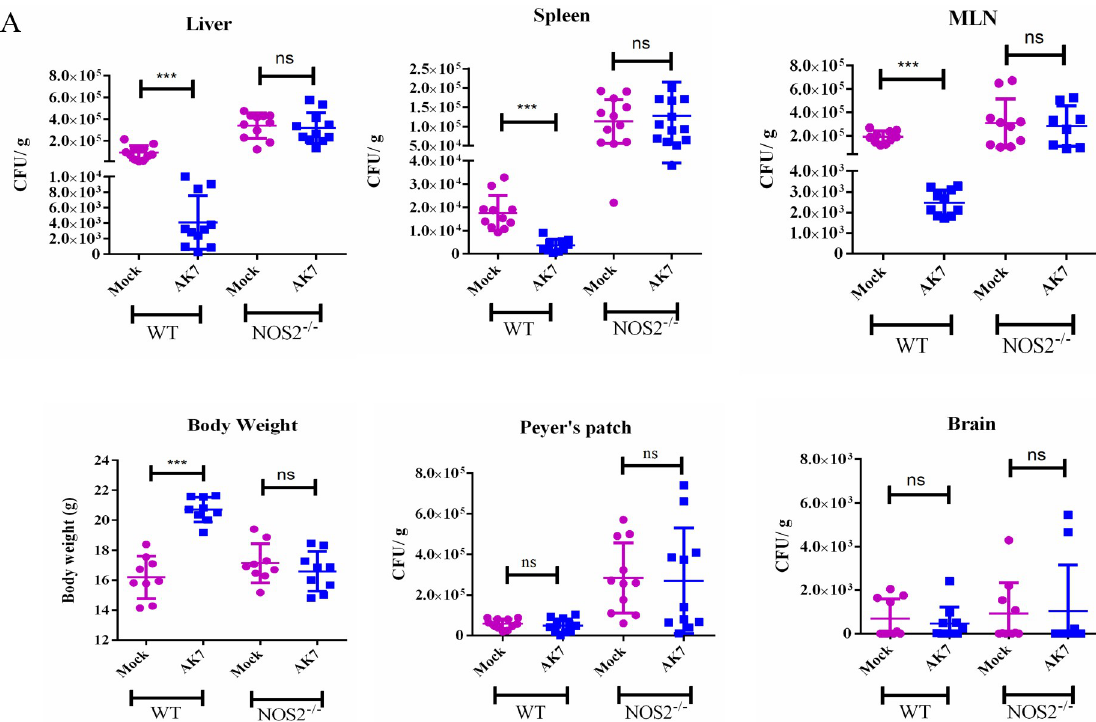
Fig 8. SIRT2 effects in vivo is NOS2 mediated. A. Organ burden in WT and NOS2 -/- mice liver, spleen, MLN, Peyer’s patch, brain and body weight in infected mice in presence and absence of SIRT2 inhibitor 5 days post infection. (Mock-only vehicle treated, AK7- 15 mg/kg bodyweight AK7 was intraperitoneally injected everyday) (Data are presented from 3 independent experiments).(unpaired two-tailed Student’s t-test, p-value, ��� < 0.0001, �� < 0.001, � <